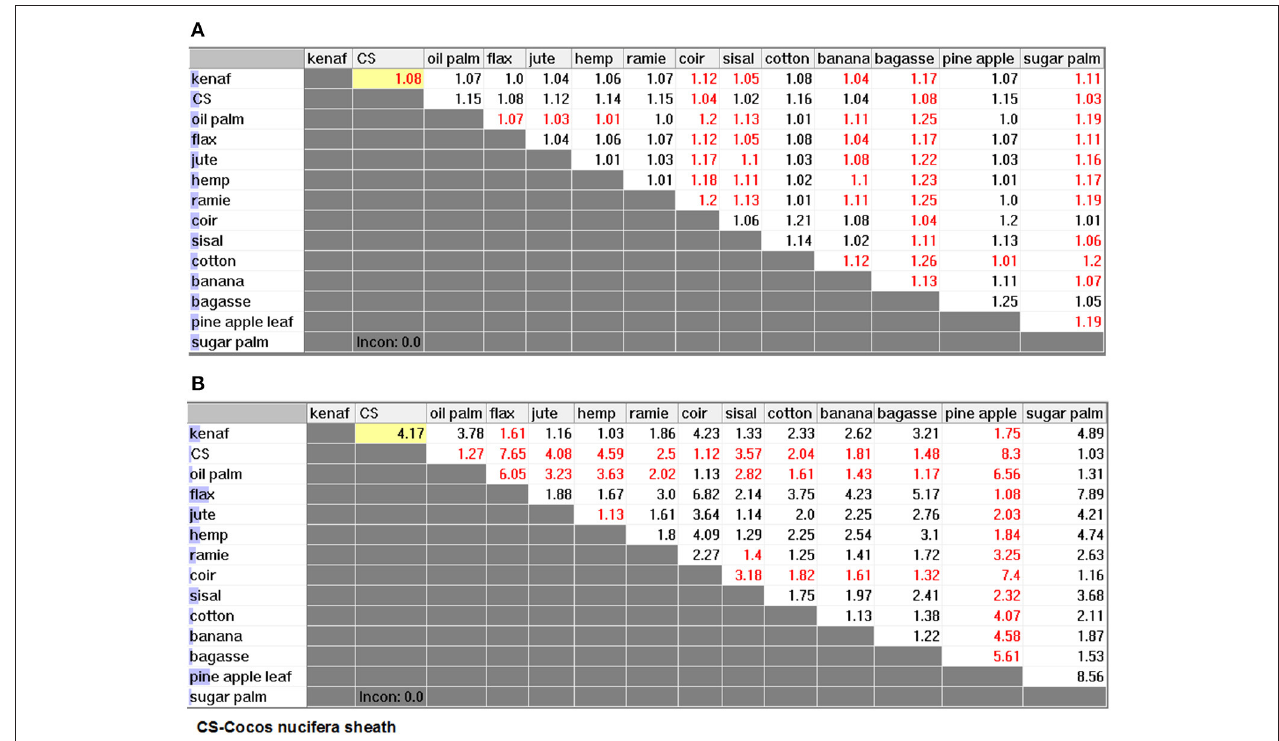
FIGURE 6 | (A) Pairwise comparison matrix of alternatives with respect to density. (B) Pairwise comparison matrix of alternatives with respect to tensile